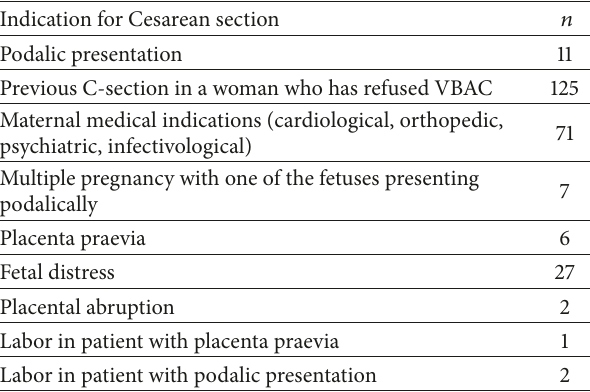
Table 1: Indication for Cesarean